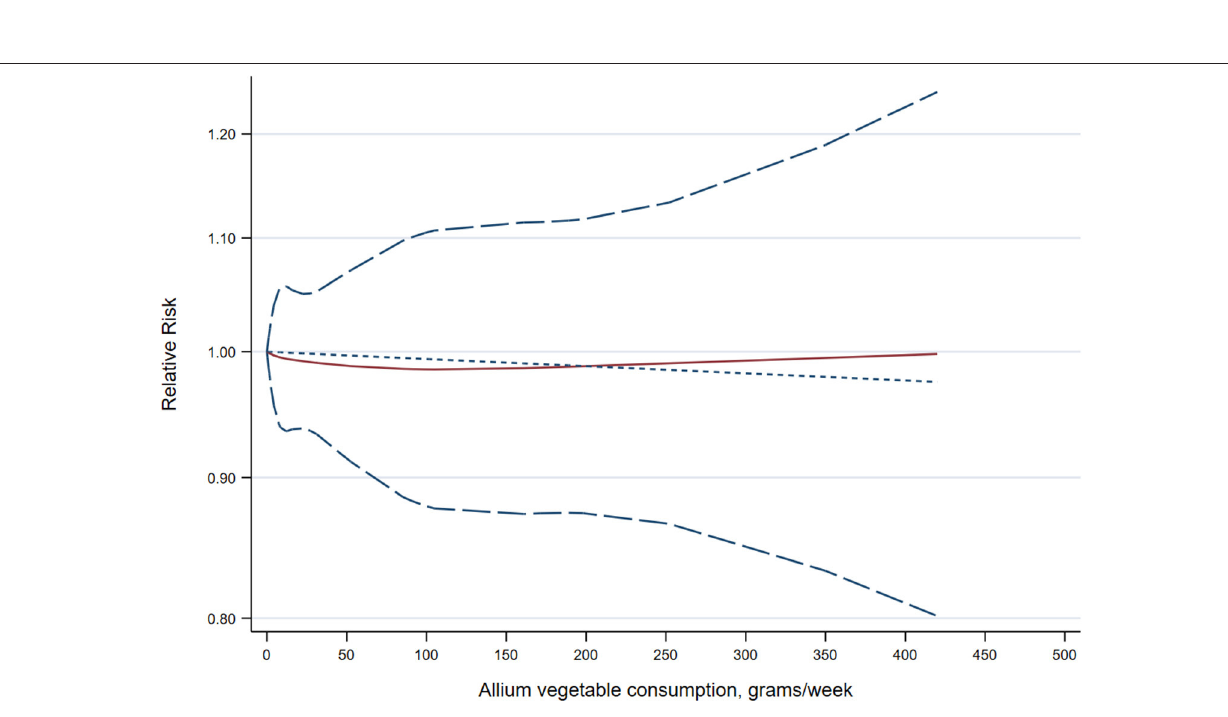
Frontiers in Nutrition |